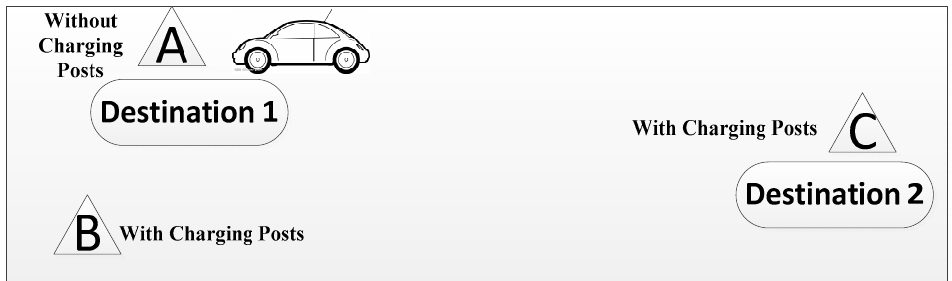
Figure 1. The scenario for testing the availability of charging posts at parking lots.